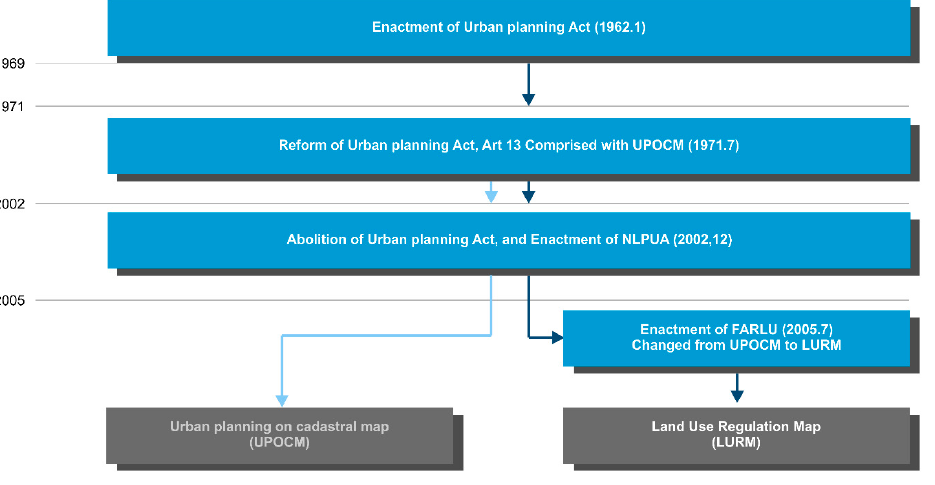
Figure 1. Changing legal process and development process from the urban planning on a cadastral map (UPOCM) to the Korean Land Use Regulation Map (LURM).